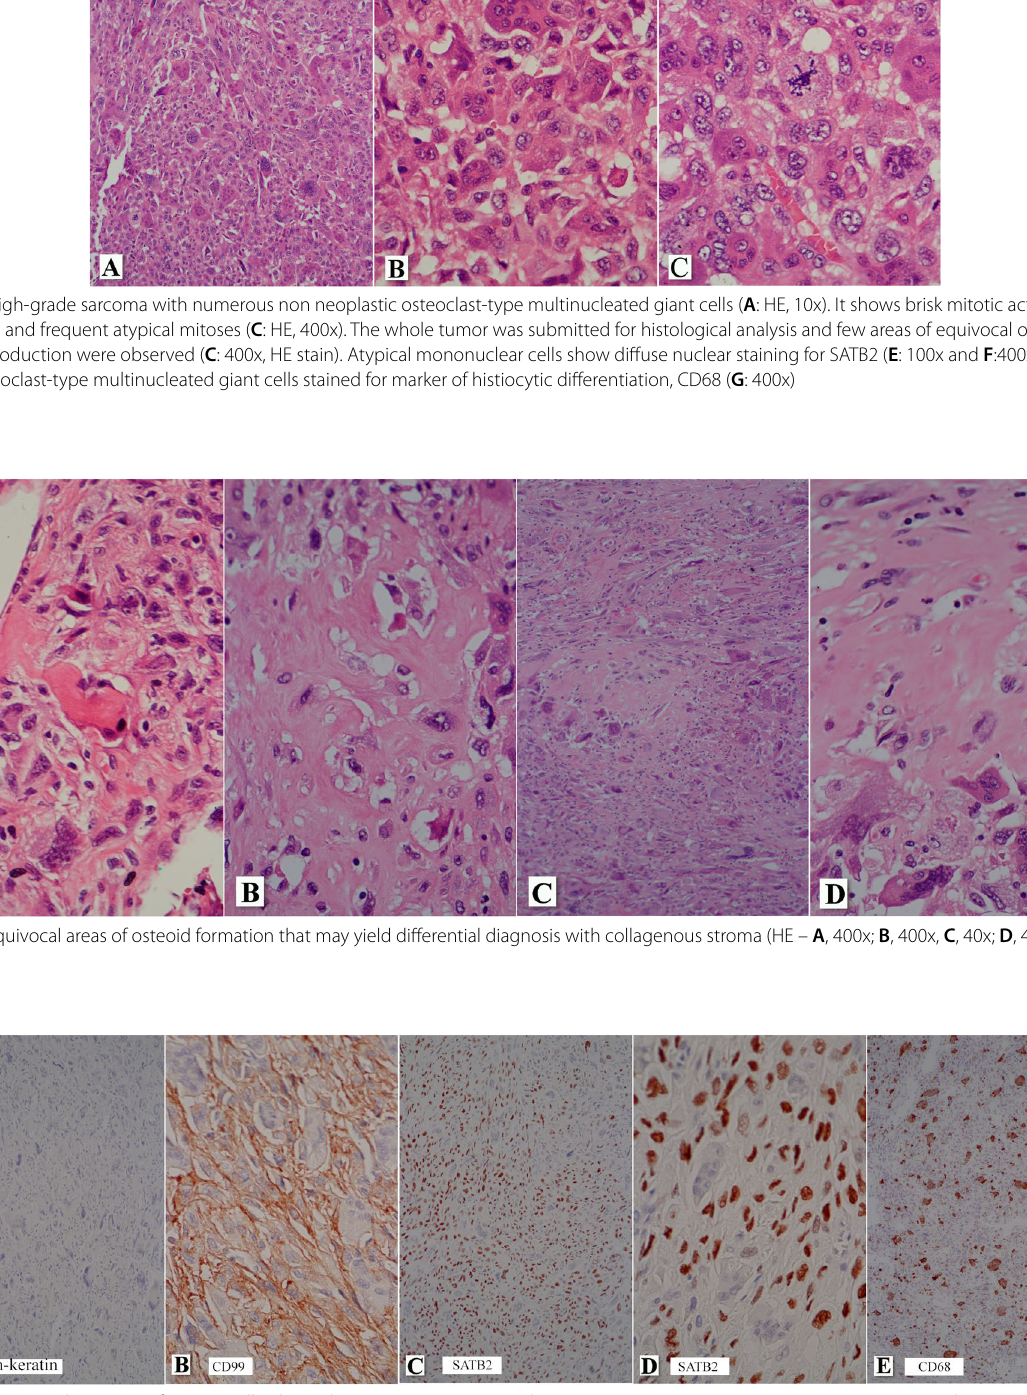
Fig. 4 Immunophenotype of a giant-cell rich penile osteosarcoma: no pan-keratin expression ( A , 40x), CD99 expression restricted to neoplastic cells ( B , 40x), SATB2 expression in tumor cells ( C , 40x; D , 400x), and CD68 positivity in giant osteoclast-type cells ( E ,